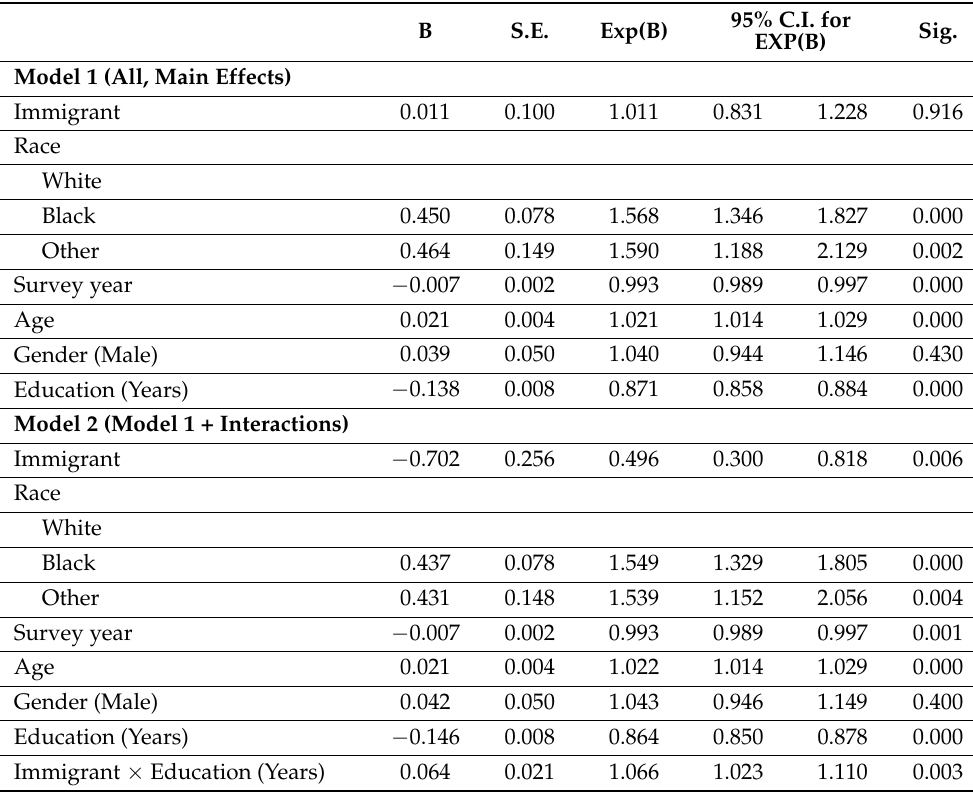
Table 2. Pooled sample logistic regression models.